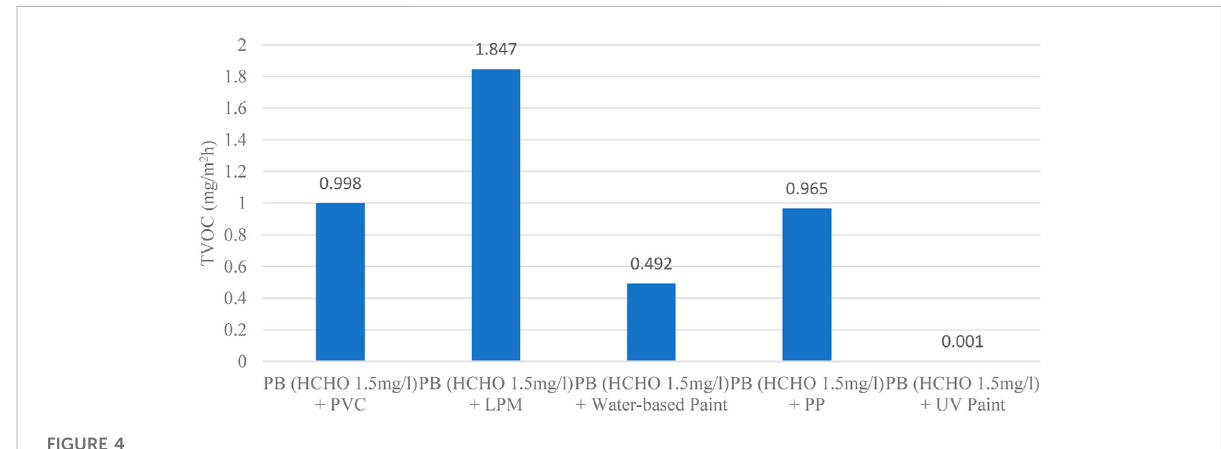
FIGURE 4 TVOC emission intensity according to fi nishing methods.